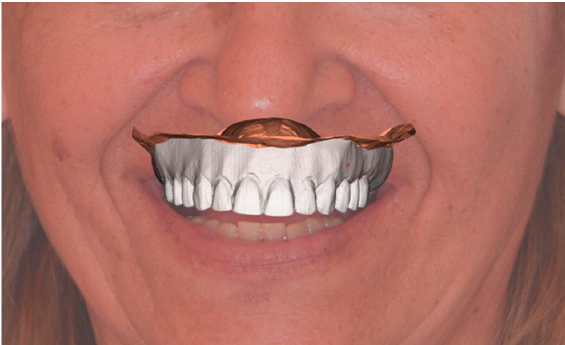
Figure 3. Three-dimensional digital project.